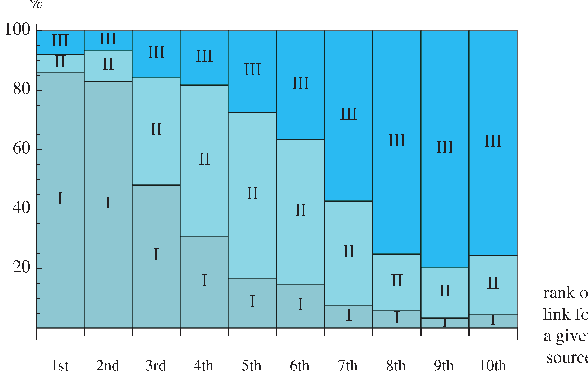
Figure 7. Most important links. Proportion of links going from sources to centers of a certain group (I, II, III), considering links of decreasing importance for each given source, when raising W (from the first link appearing, at left, to the last link, at